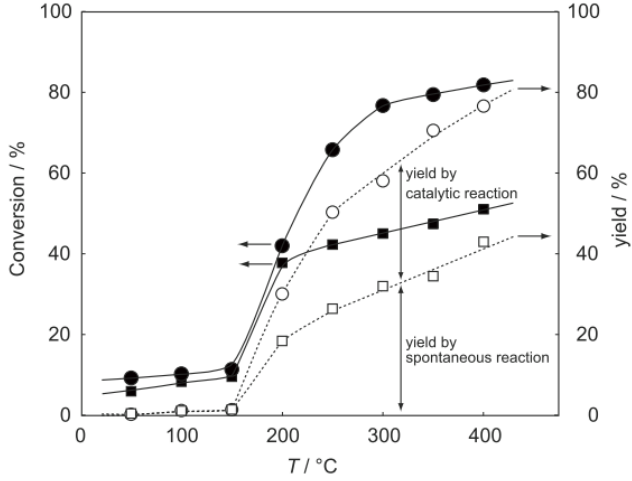
Figure 20. Effect of temperature on the S -alkylation of benzenethiol with 1-hexene in the presence and absence of [(Nb Cl )Cl (H O) ]·4H O/SiO . Following the activation of 6 12 2 2 4 2 2 the supported cluster (10 mg, 0.42 μmol) in a hydrogen stream (300 mL/h) for 1 h, reaction was initiated by introduction of benzenethiol (22 μL/h, 0.20 mmol/h) and 1-hexene (250 μL/h, 2.0 mmol/h) to the stream without changing the temperature. Other conditions are the same as in Figure 19. Yield of n -hexyl phenyl sulfide = conversion × (selectivity for n -hexyl phenyl sulfide)/100 (mol%) based on benzenethiol. Conversion of benzenethiol in the presence (●); and absence of the supported cluster (■); and yield of n -hexyl phenyl sulfide in the presence (○); and absence of the supported cluster (□); at 3 h after the start of the